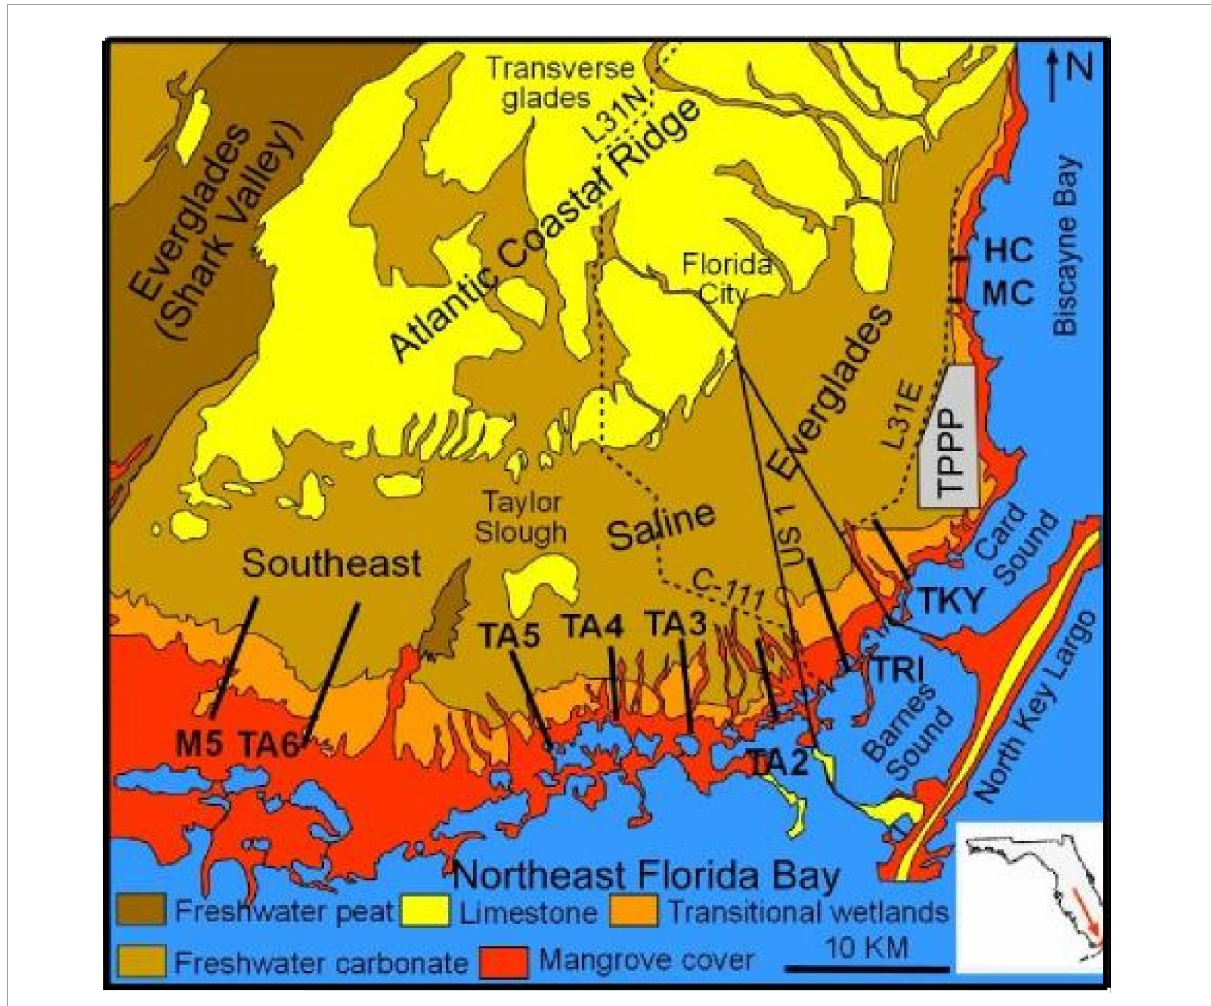
FIGURE1 Study area. The heavy black lines are the transect locations. HC, Historic Creek. MC, Mowry Canal. TKY, Turkey Point, TRI, Triangle transect. TA and M5 are locator labels with no specific meaning TPPP, Tukey Point Nuclear Power Plant 210 Pb dating was performed on the following cores collected in 1995; TPE, LHC, and CHC (equivalent to 2017 transect TA2), CJB, LJB, and UJB (equivalent to 2017 transect TA3), and EVER 4 and EVER 7 are north of 2017 transect TA4 (Meeder et al., 1996). Core collected in 2017 include EVERl north of TRI, TA2.2, TA2.4, and TA2.6 from transect TA2. TA3.4 and 3.5 are from transect TA3, and EPIOR is found along transect TA4. Locations of 2017 cores along the transects are located in Figure 7 and the distance to the coast for all 2017 cores are listed ( Table 4